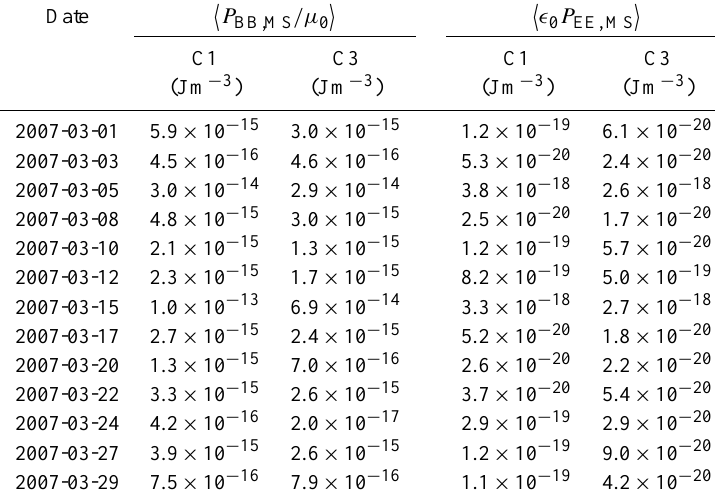
Table 3. Magnetosheath mean energy density of the magnetic h P BB /µ 0 i and electric h (cid:15) 0 P EE i fluctuations in the frequency range 10Hz ≤ f ≤ 500Hz. The values are computed from data taken during the first 10min spent in the magnetosheath after the last plasmoid was seen by Cluster 1 and 3, respectively, on each date